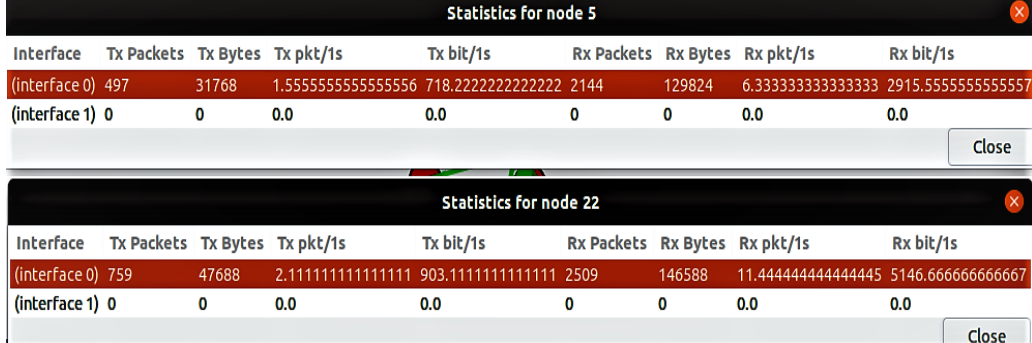
Figure 18. PyViz